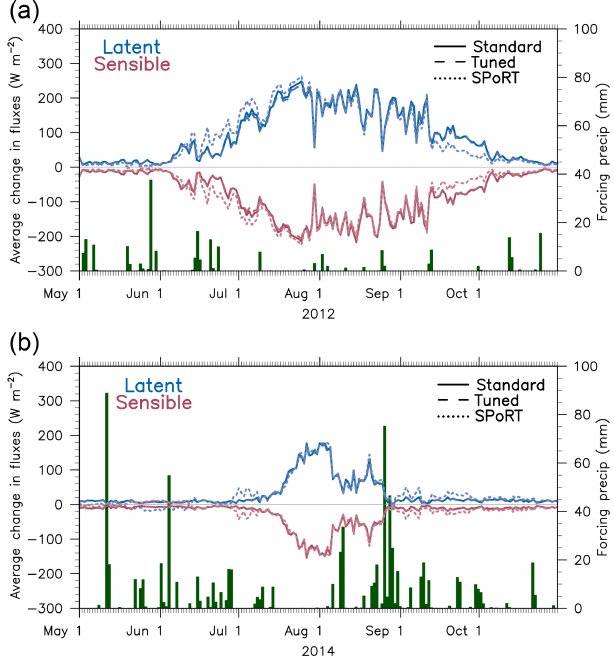
Figure 5. May to September domain average daily change (i.e., irri- gation runs – Control) in latent (blue) and sensible (red) heat fluxes (left axis) for (a) 2012 and (b) 2014. Also shown is the domain average daily precipitation from the NLDAS-2 forcing data (right